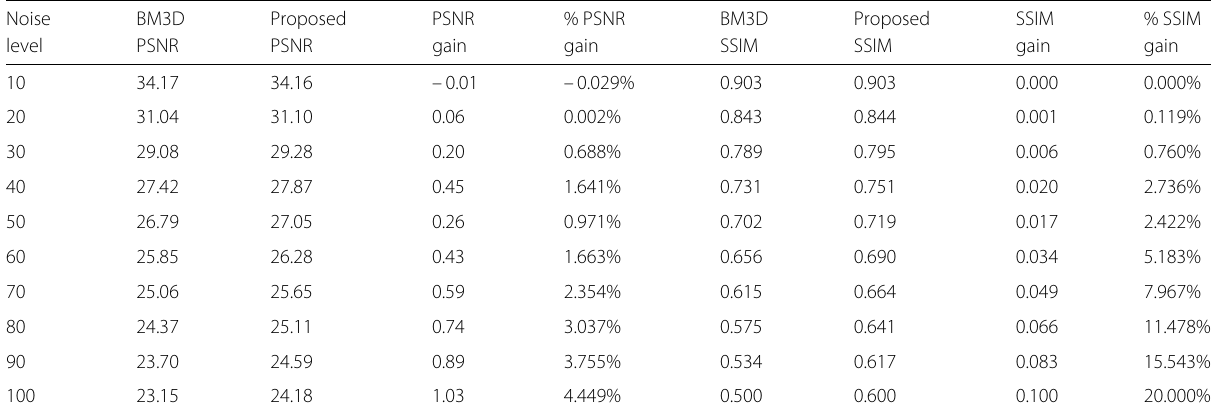
Table 2 Performance comparison of normal profile and proposed method Noise